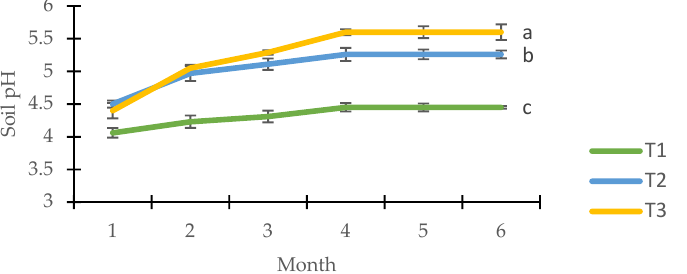
Figure 1. Effects of different amendments on soil pH ( n = 3). Vertical bars represent the standard deviation. Different letters indicate a significant difference ( p < 0.05) amongst treatments in the final planting period.